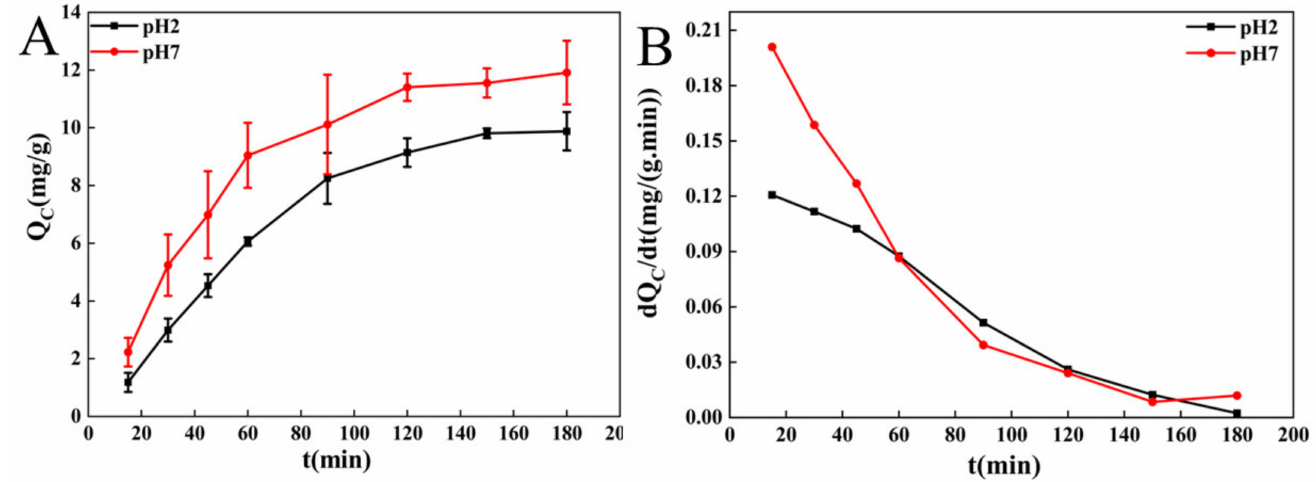
Figure 1. Adsorption curves ( A ) and adsorption speed curves ( B ) of cholesterol onto BC at differ- ent